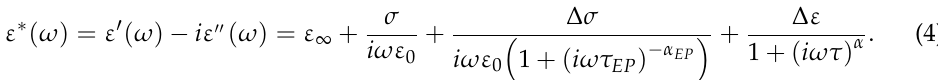
and T is the temperature. The dependence ln τ vs (1000/T) for a hydrate formed without an inhibitor has a break; with a decrease in temperature, the activation energy changes from 54 ± 0.5 kJ/mol